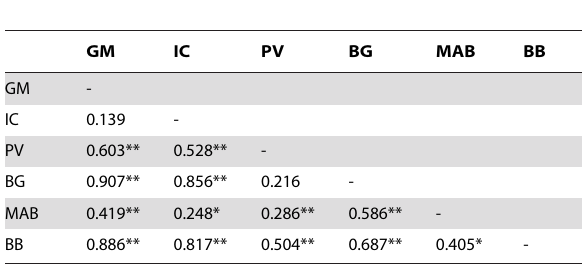
Table 2. Relationships among the three Oithona species based on 28S rDNA.